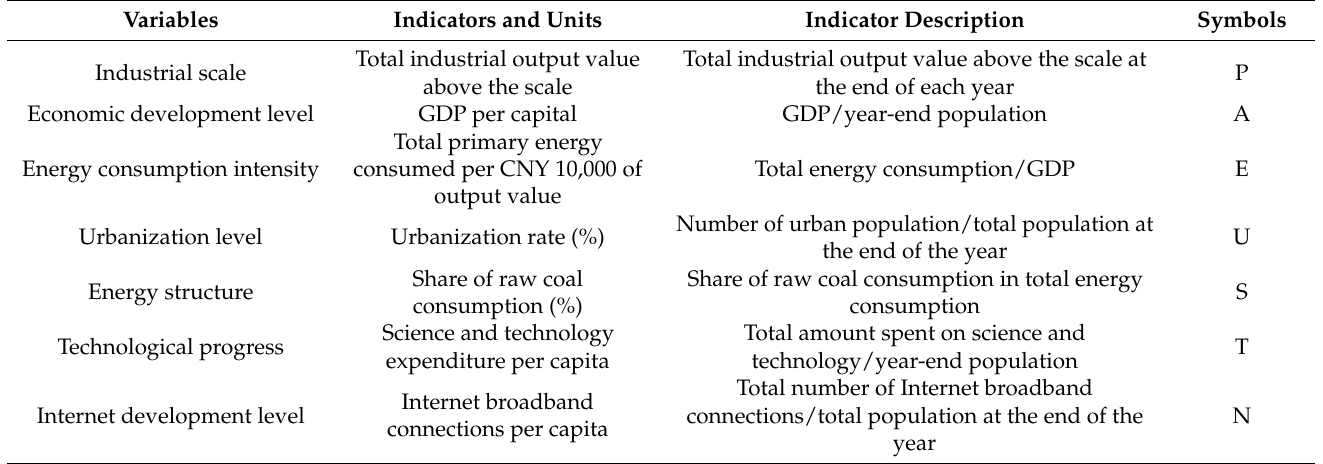
Table 2. Carbon emission impact factor